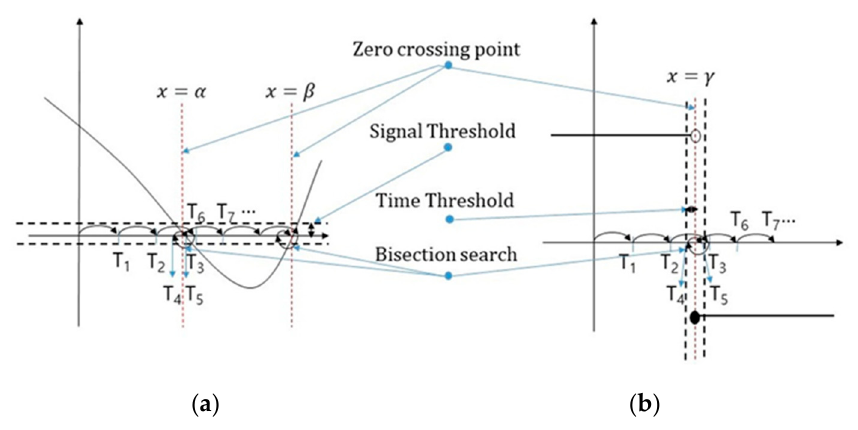
Figure 5. Zero crossing point and bi-section search; ( a ) continuous model, ( b ) discontinuous model.